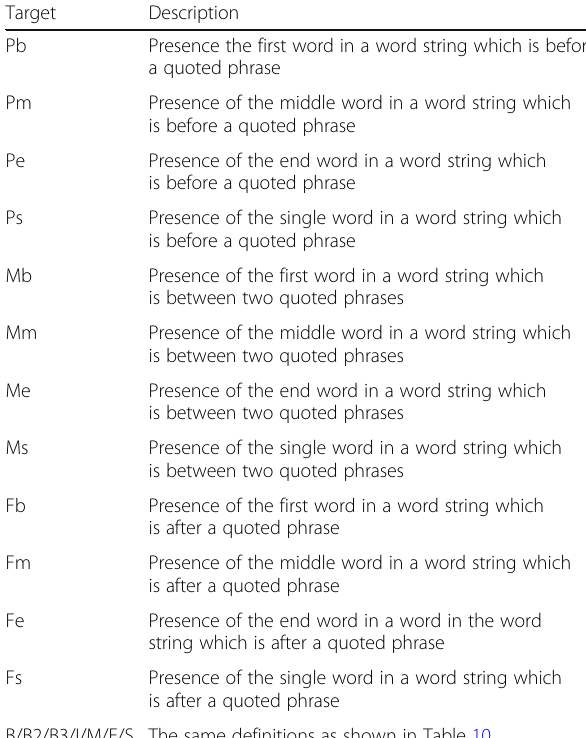
Table 11 Tag format for labeling of target QPs for sQC